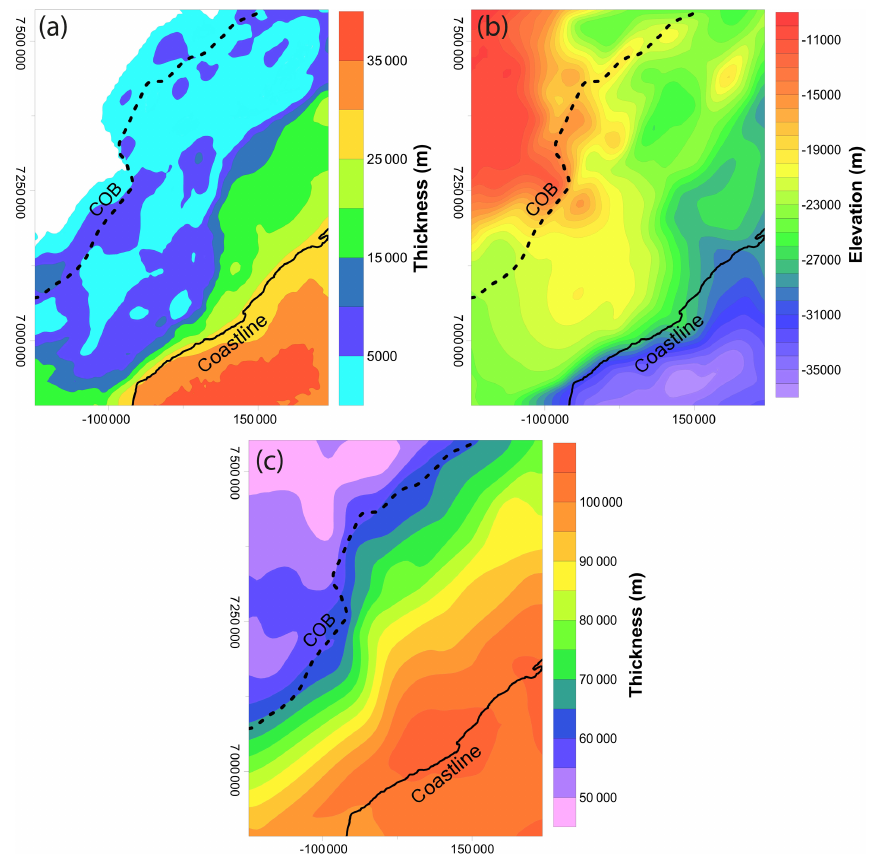
Figure 6. 3-D structural model of the Norwegian margin: (a) thickness of the upper crystalline crust; (b) depth to Moho; (c) thickness of the lithospheric mantle at the Norwegian continental margin.